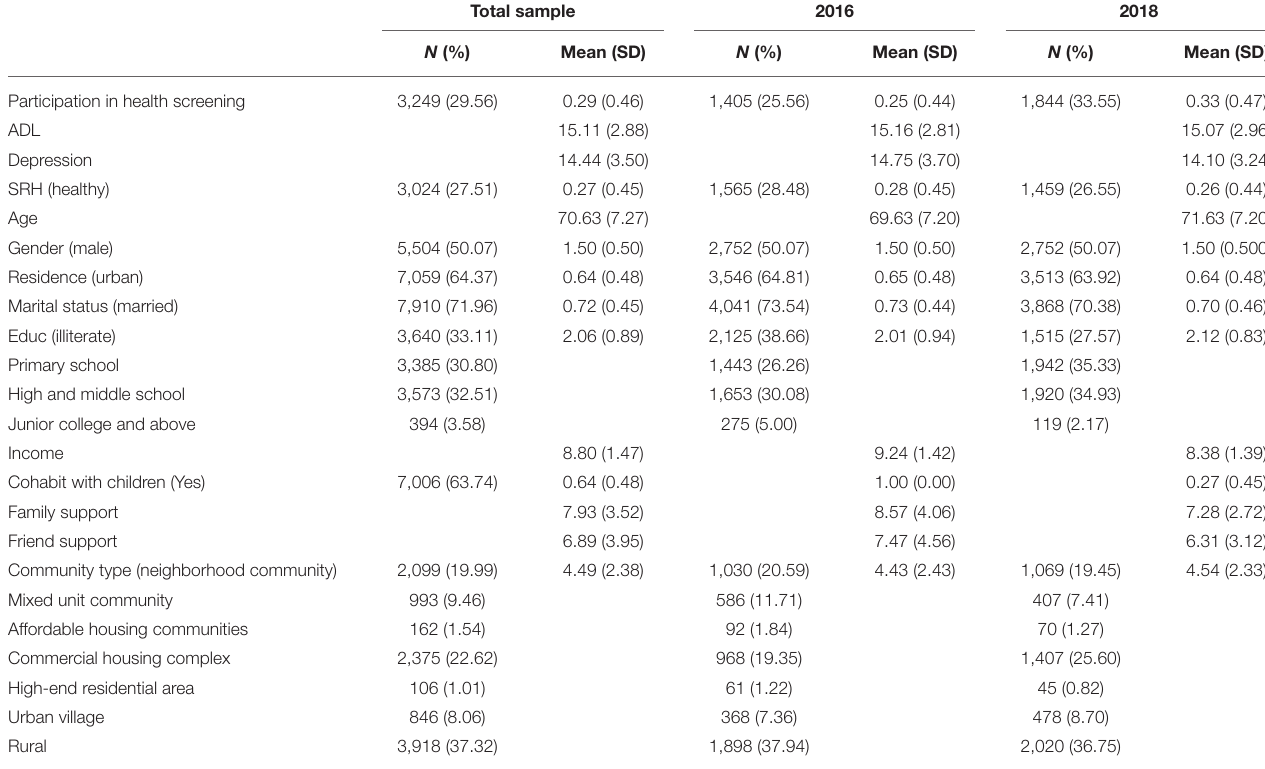
TABLE 1 | Basic information of all variables.